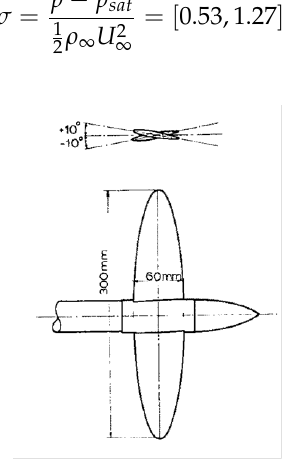
Figure 2. Schematic view of the